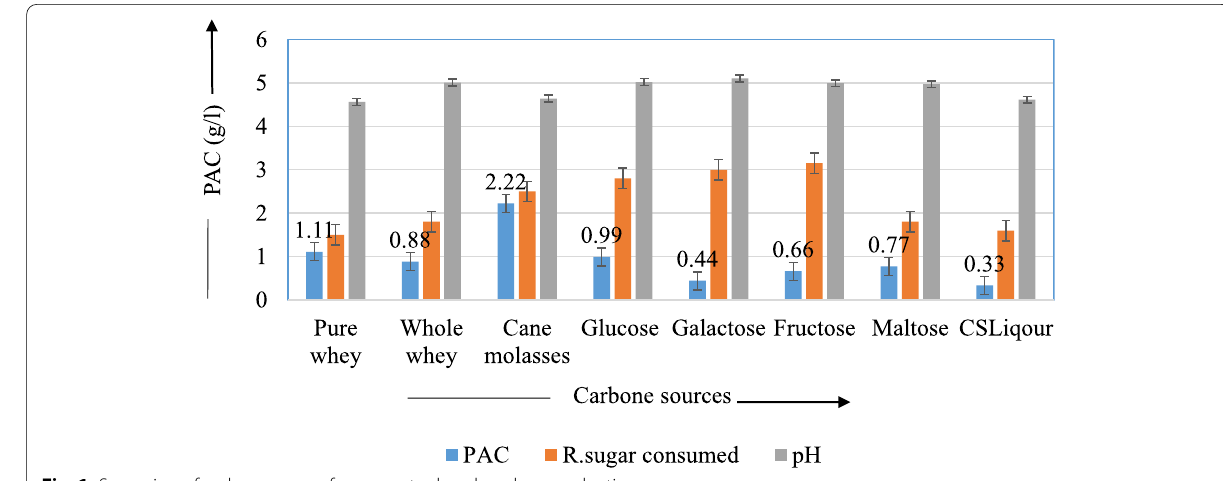
Fig. 1 Screening of carbon sources for pyruvate decarboxylase production